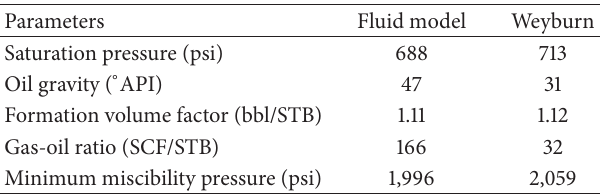
Table 2: Comparison between properties of fluid model and Weyburn